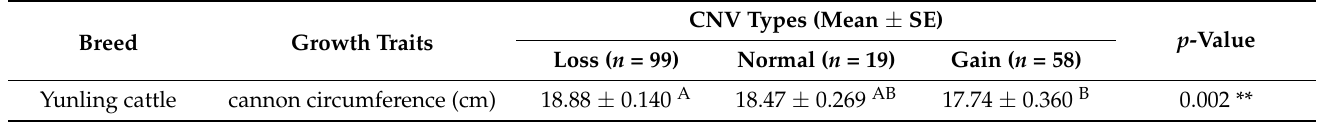
Table 2. Association analysis of CLCN2 gene CNV1 with growth traits in YL cattle.